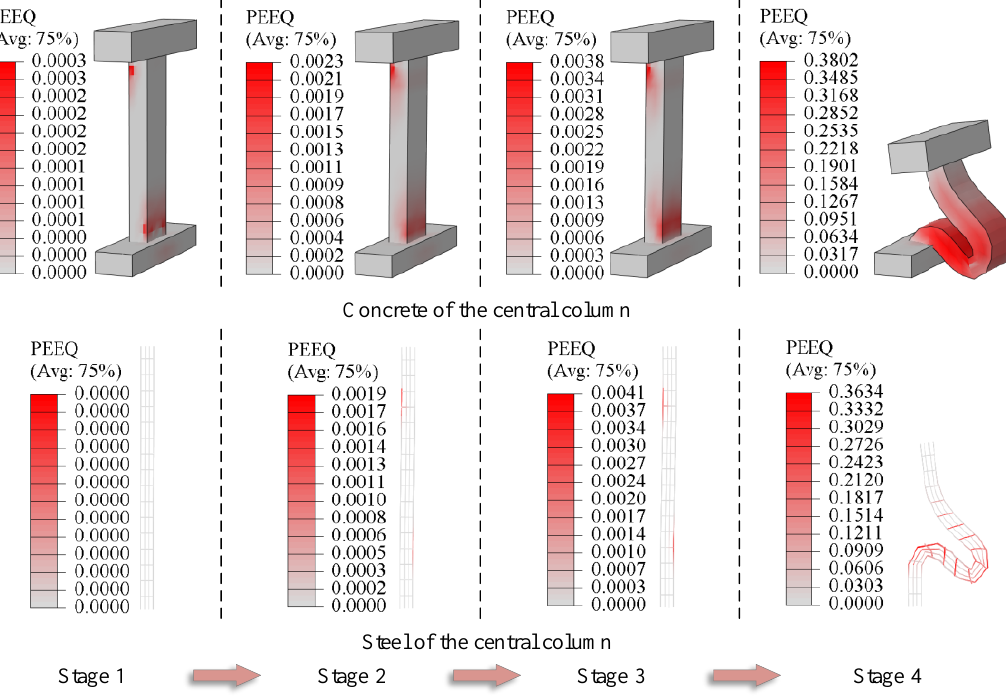
Figure 14. Equivalent plastic strain of the column and steel during pushover.